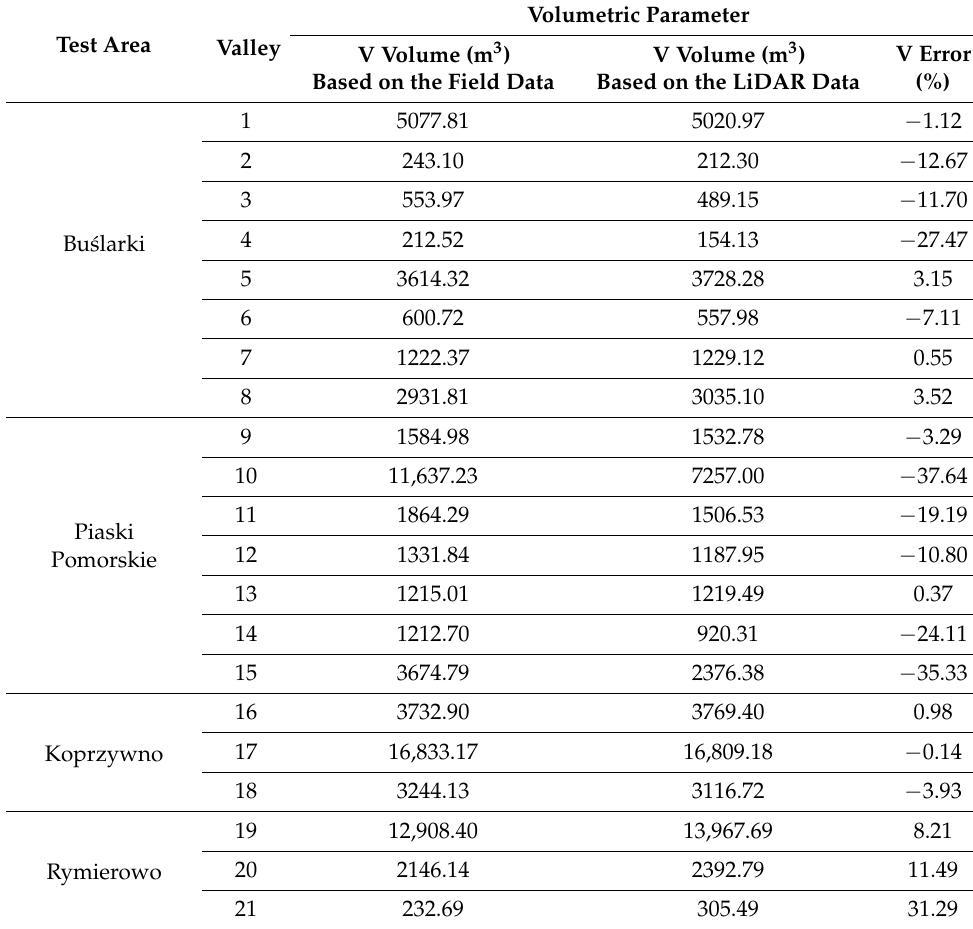
Table 7. Volumetric parameter of the erosion-denudation